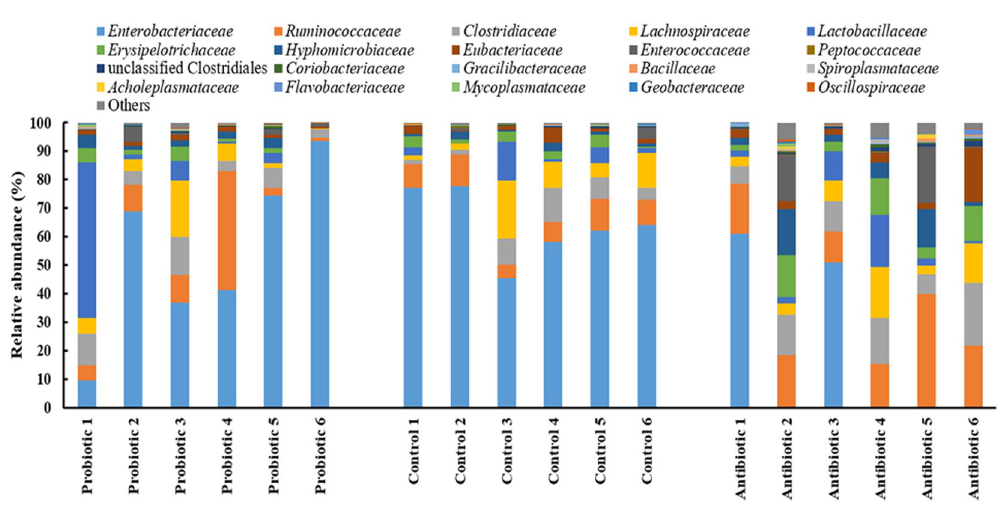
Figure 4. Abundant bacterial families present in the cecum microbiota of broilers from the different treatment